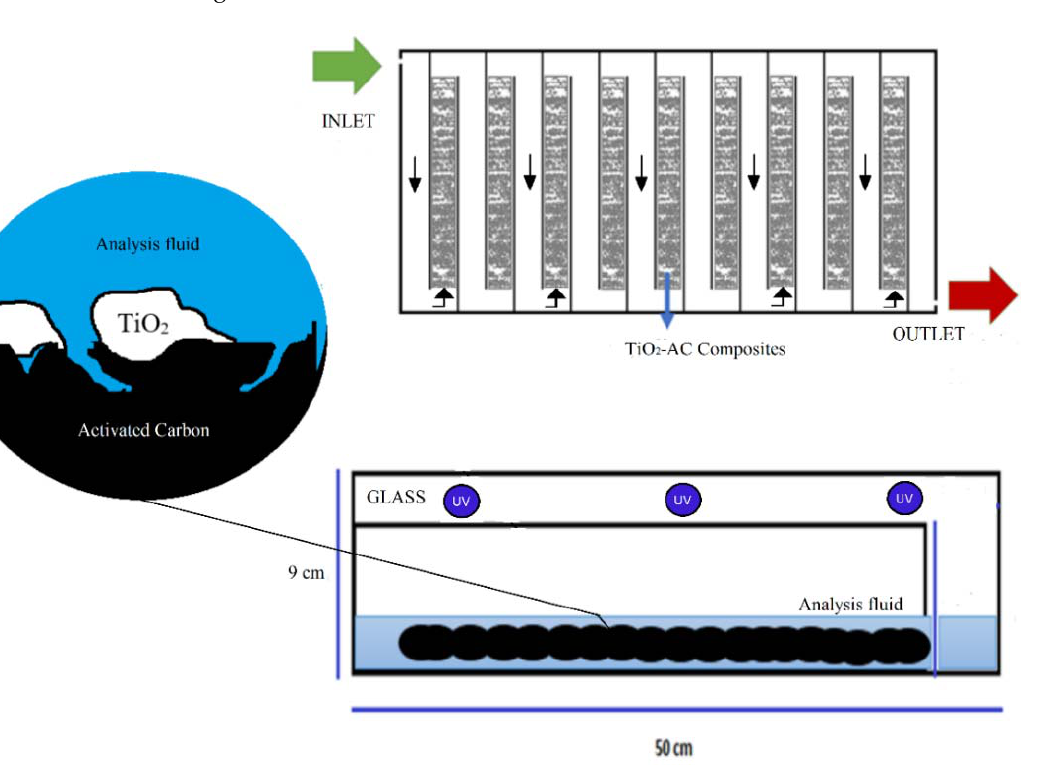
Table 2. Physical and chemical properties of